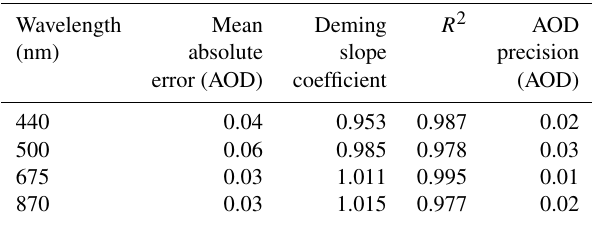
Table 2. Summary statistics for AMODv2 vs. AERONET co- located